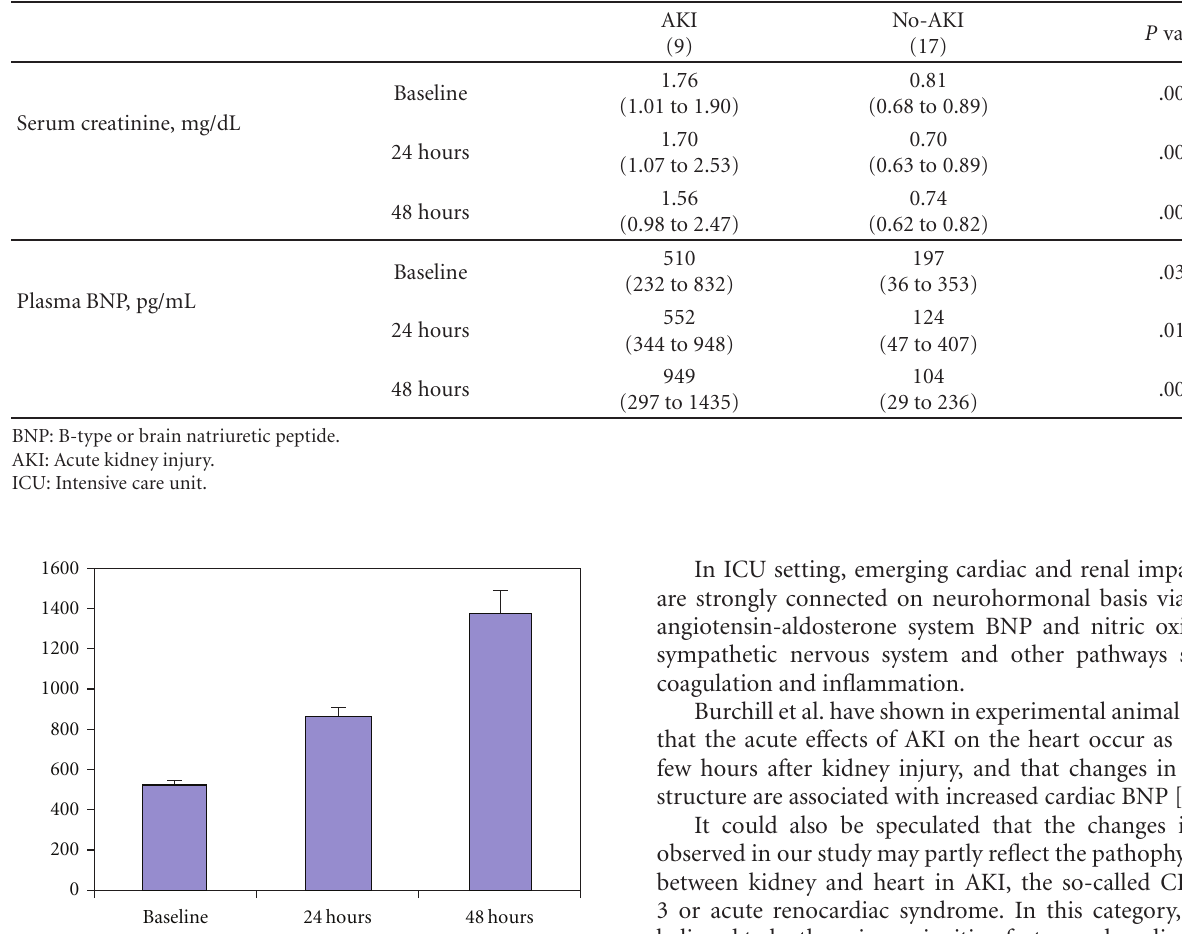
Table 4: Median of creatinine and BNP during 48 hours for patients developing AKI or not any time during their ICU stay.